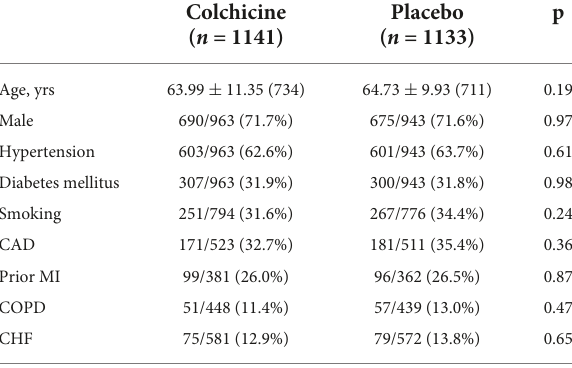
TABLE 2 Overall baseline characteristics of pooled groups of colchicine and placebo patients.